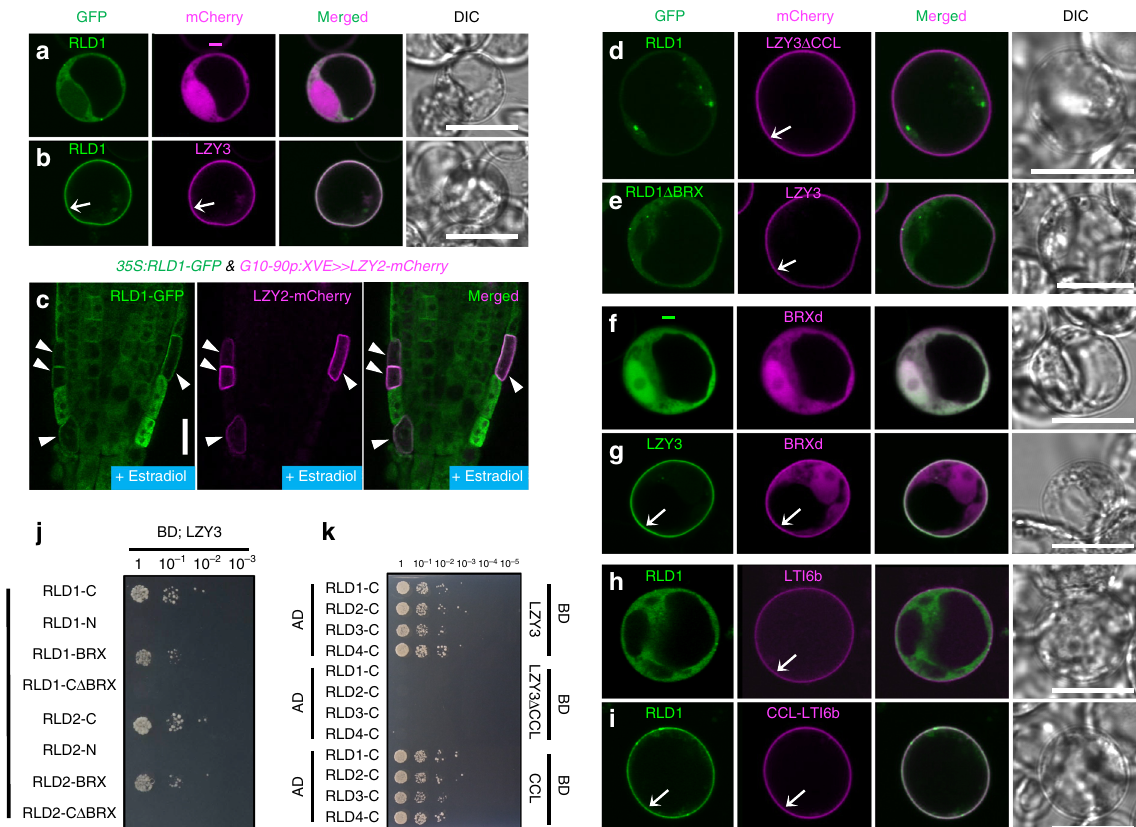
Fig. 3 LZY recruits RLD to the plasma membrane via the CCL-BRX interaction. a , b Co-expression of RLD1-GFP with mCherry ( a ) and LZY3-mCherry ( b ) in Arabidopsis protoplast cells. Arrows indicate plasma membrane-localized signals. c Localization of RLD1-GFP (left) and LZY2-mCherry (middle) in primary root of 8-day-old seedling harboring 35S:RLD1 - GFP and G10-90p:XVE»LZY2 - mCherry , transferred to MS medium plate containing 1 μ M estradiol at 7 days old. Merged image of RLD1-GFP and LZY2-mCherry (right). Arrowheads indicate LZY2-mCherry-expressing cells, where RLD1-GFP was co-localized with LZY2-mCherry in the plasma membrane. d , e Co-expression of RLD1-GFP and CCL-deleted LZY3-mCherry (LZY3 Δ CCL) ( d ), and of the BRX domain- deleted RLD1-GFP (RLD1 Δ BRX) and LZY3-mCherry ( e ) in Arabidopsis protoplast cells. f , g Co-expression of the BRX domain (BRXd)-mCherry with GFP ( f ) and LZY3-GFP ( g ) in Arabidopsis protoplast cells. h , i Co-expression of RLD1-GFP with mCherry-LTI6b ( h ) and CCL-mCherry-LTI6b ( i ) in Arabidopsis protoplast cells. Scale bars, 10 μ m ( a , b , d – i ) and 20 μ m ( c ). j , k Interaction between LZY3 and truncated forms of RLD1 and RLD2 ( j ), and between C terminus of RLDs and truncated forms of LZY3 ( k ) in the Y2H system. Interaction was indicated by growth on selection medium lacking leucine, tryptophan, histidine, and